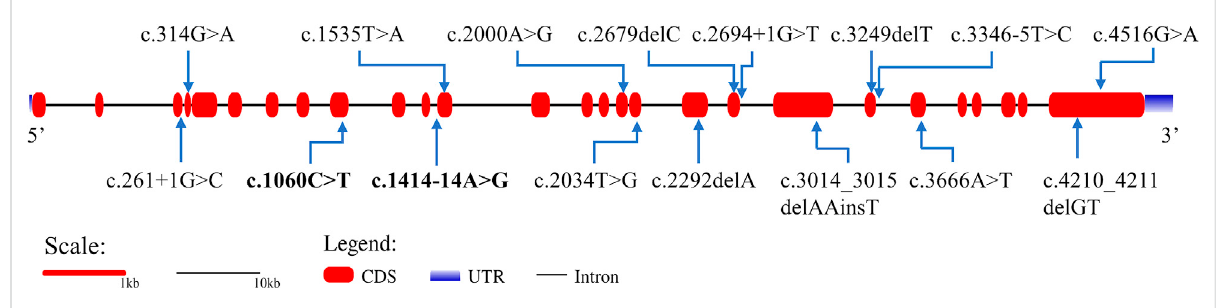
The red boxes represent the coding sequence (CDS). The blue gradient boxes represent the 5 ′ and 3 ′ untranslated regions (UTR).